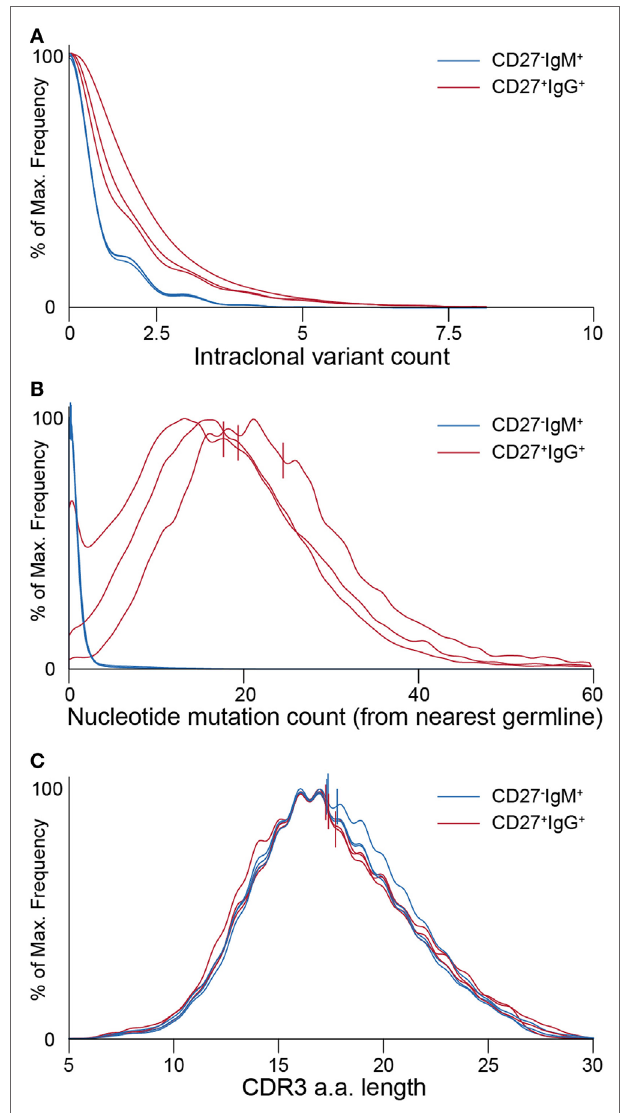
FIgURe 5 | Ig-seq analysis of molecular features highlight global differences between naïve (CD27 − IgM + ) and memory (CD27 + IgG + ) B cells. (A) Clonotype size (calculated as the total number of variants within a clonotype) for naïve IgM (blue lines) and memory IgG (red lines) B cells. Each pair of lines represents a single donor. (B) Graph showing the distribution of average somatic hypermutation (SHM) frequencies for VDJ nt variants per clonotype. The CD27 − IgM + B cell repertoires (blue lines) have a median SHM value of 0, whereas only a small fraction of clonotypes (approximately 8%) contain an average of one or more mutations. CD27 + IgG + repertoires (red lines) have a median of 20 to 24 SHM per nt variant within each clonotype. (c) Complementarity determining region 3 (CDR3) a.a. length distribution across clonotypes from naïve (blue lines) and memory (red lines) B cell subsets. Vertical lines in panels (B,c) denote mean